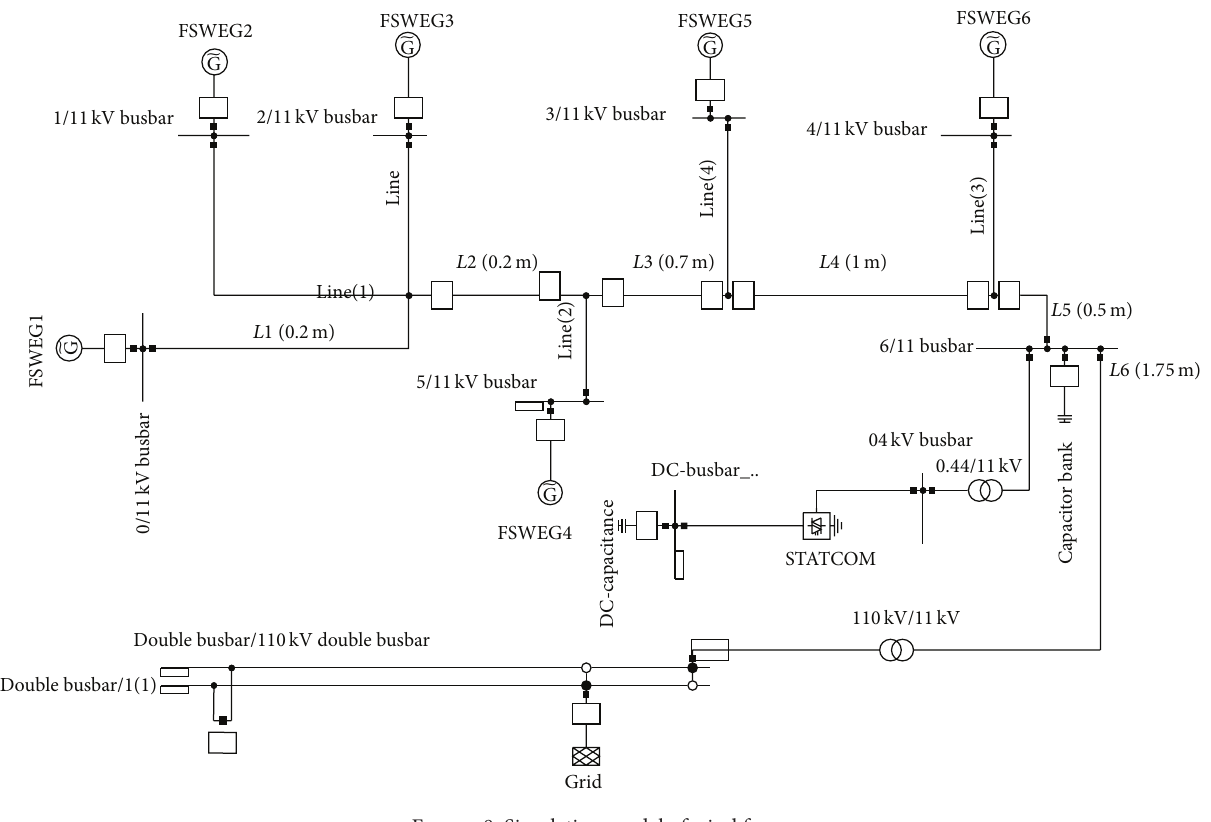
Figure 8: Simulation model of wind farm.